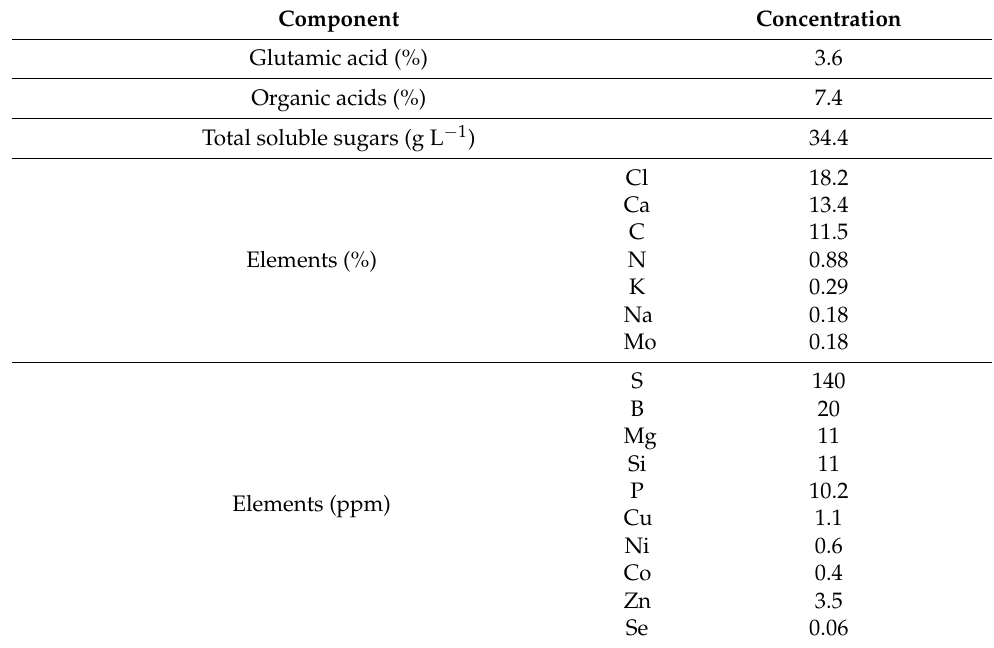
Table 1. Composition of the VNT4